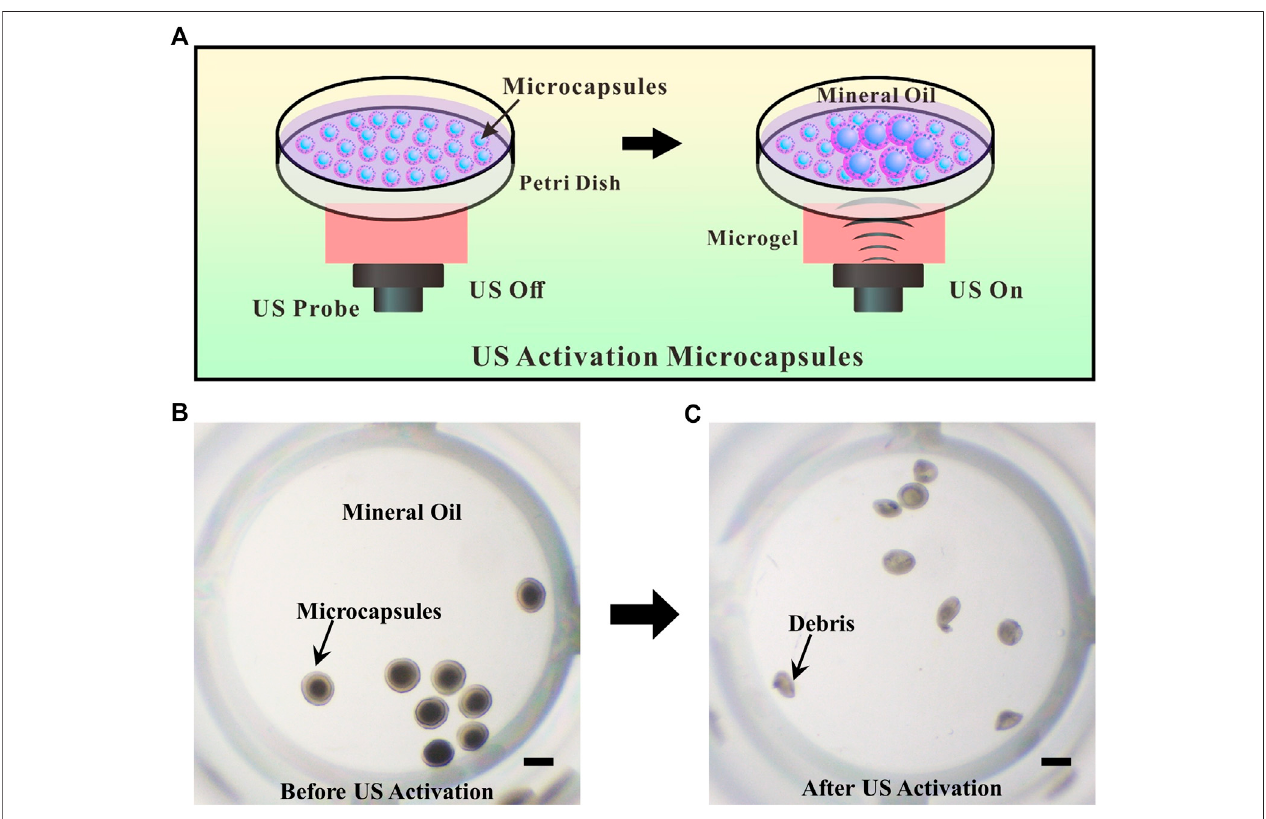
FIGURE 5 | (A) Schematic illustration of US activation of PMHMs. (B) Microscopic image of the produced PMHMs in a 96-well plate before US activation. (C) Microscopic image of the produced PMHMs after US activation. Scale bar: 500 μ